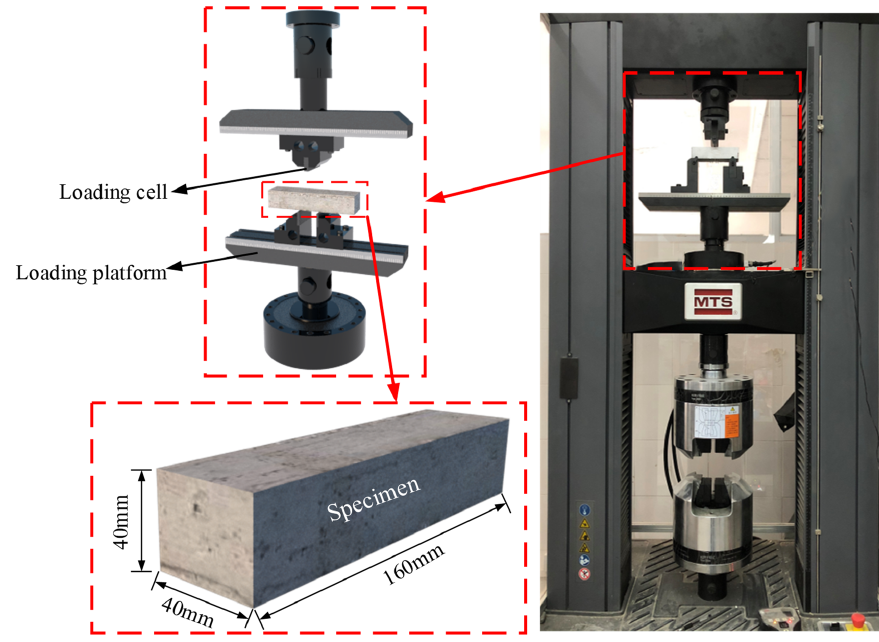
Figure 1. Test setup and specimens.